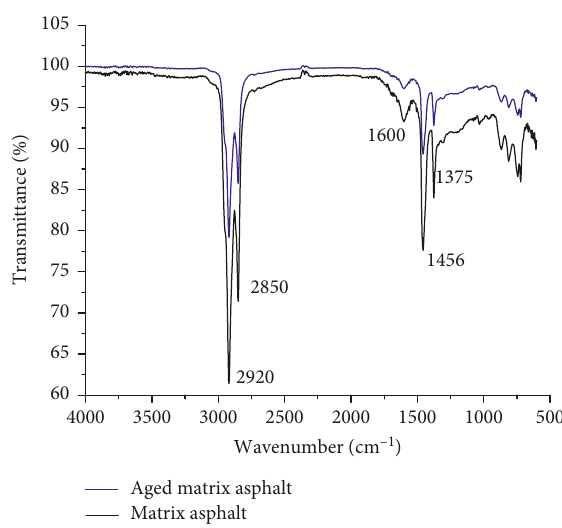
Figure 12: FTIR spectra of original and aged matrix asphalt.